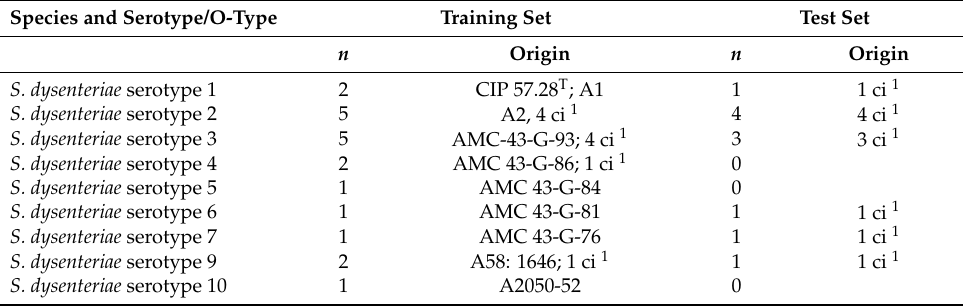
Table 1. Isolates used in this study are divided into training and test sets. Species and Serotype/O-Type Training Set Test Set n